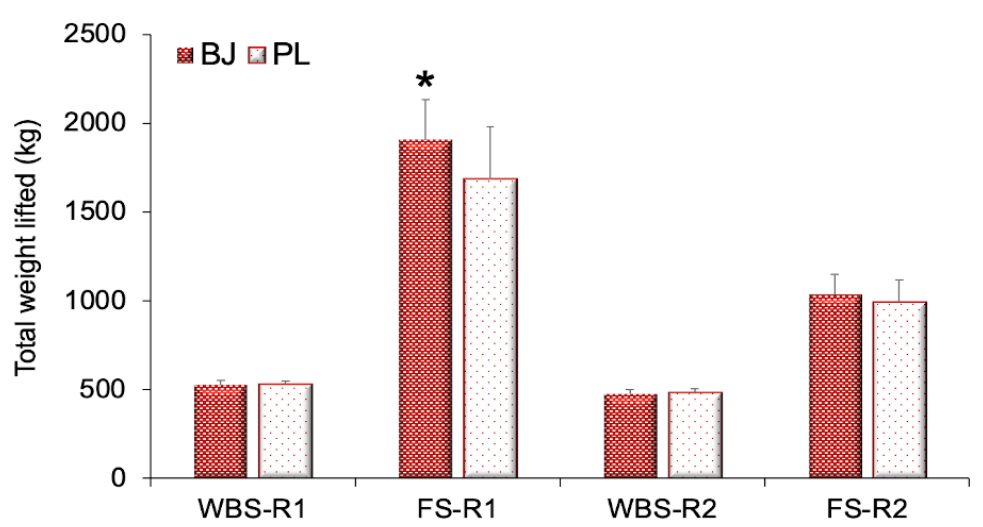
Figure 2. Total weight lifted ( n = 11). Abbreviations used: BJ: beetroot juice; FS-R1: full squat dur- ing the first routine; FS-R2: full squat during the second routine; PL: placebo; WBS-R1: wall ball shots during the first routine; WBS-R2: wall ball shots during the second routine. Data are pro- vided as mean and error bars as 95% confidence intervals. * Significant increase in the total weight lifted after BJ intake compared with the PL condition in the first routine (with a 3 min rest) ( p = 0.004).